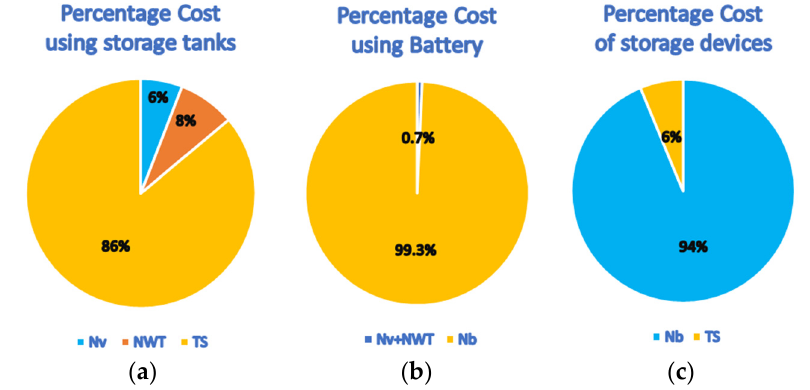
Figure 8. Contribution of the major plant components in the capital cost.